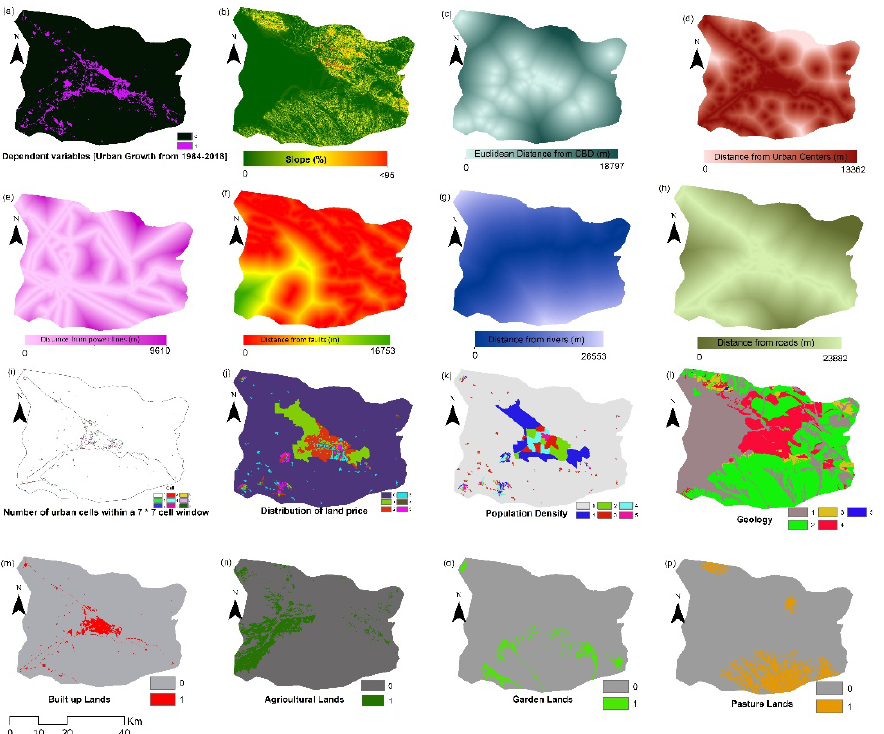
Figure 5. Raster layers of independent variables. ( a ). dependent variable (urban growth 1984 to 2018), ( b ). slope(percent), ( c ). distance from CBD (m), ( d ). distance from urban centers (m), ( e ). dis- tance from power lines (m), ( f ). distance from faults (m), ( g ). distance from rivers (m), ( h ). distance from roads(m), ( i ). distance from rivers (m), ( j ). number of urban cells within a 7 · 7 cell window, ( k ). distribution of land price, ( l ). Geology, ( m ). Built up lands, ( n ). agricultural lands, ( o ). garden lands, ( p ). pasture lands.